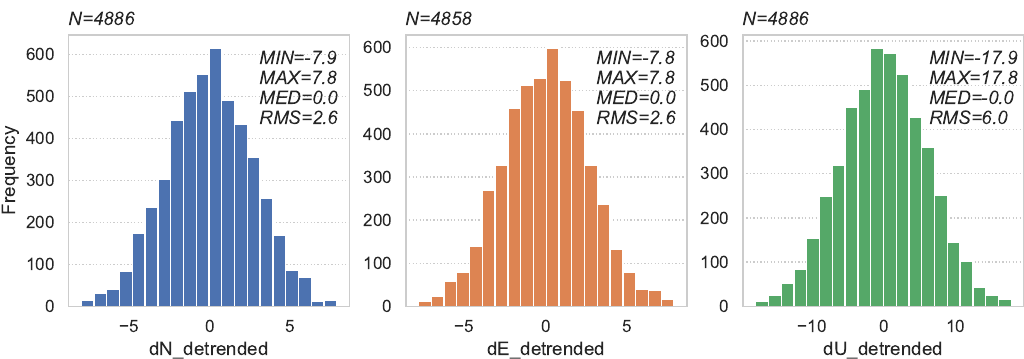
Figure 9. Error distribution of the RTKLIB solution with respect to the GIPSY solution in terms of local NEU offsets. Outlier and trend removal was carried out before computing the differences [unit: mm].